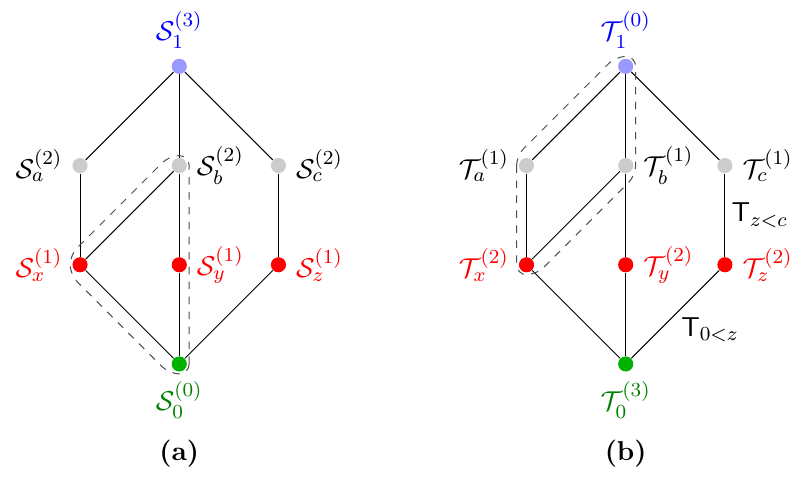
Figure 3. Hasse diagram of a 3-dimensional scale-invariant Coulomb branch. Figure (a) shows the nodes labelled by the strata S ( d ) non-singular points of the Coulomb branch, S (0) of the strata enclosed by the dashed line is the component S (2) Figure (b) labels the nodes by the theories T ( r ) theory and i is the same unique stratum label. T (3) and the nodes enclosed by the dashed line form the Hasse diagram of the Coulomb branch of the T (2) x theory. A few edges have also been labelled by their elementary